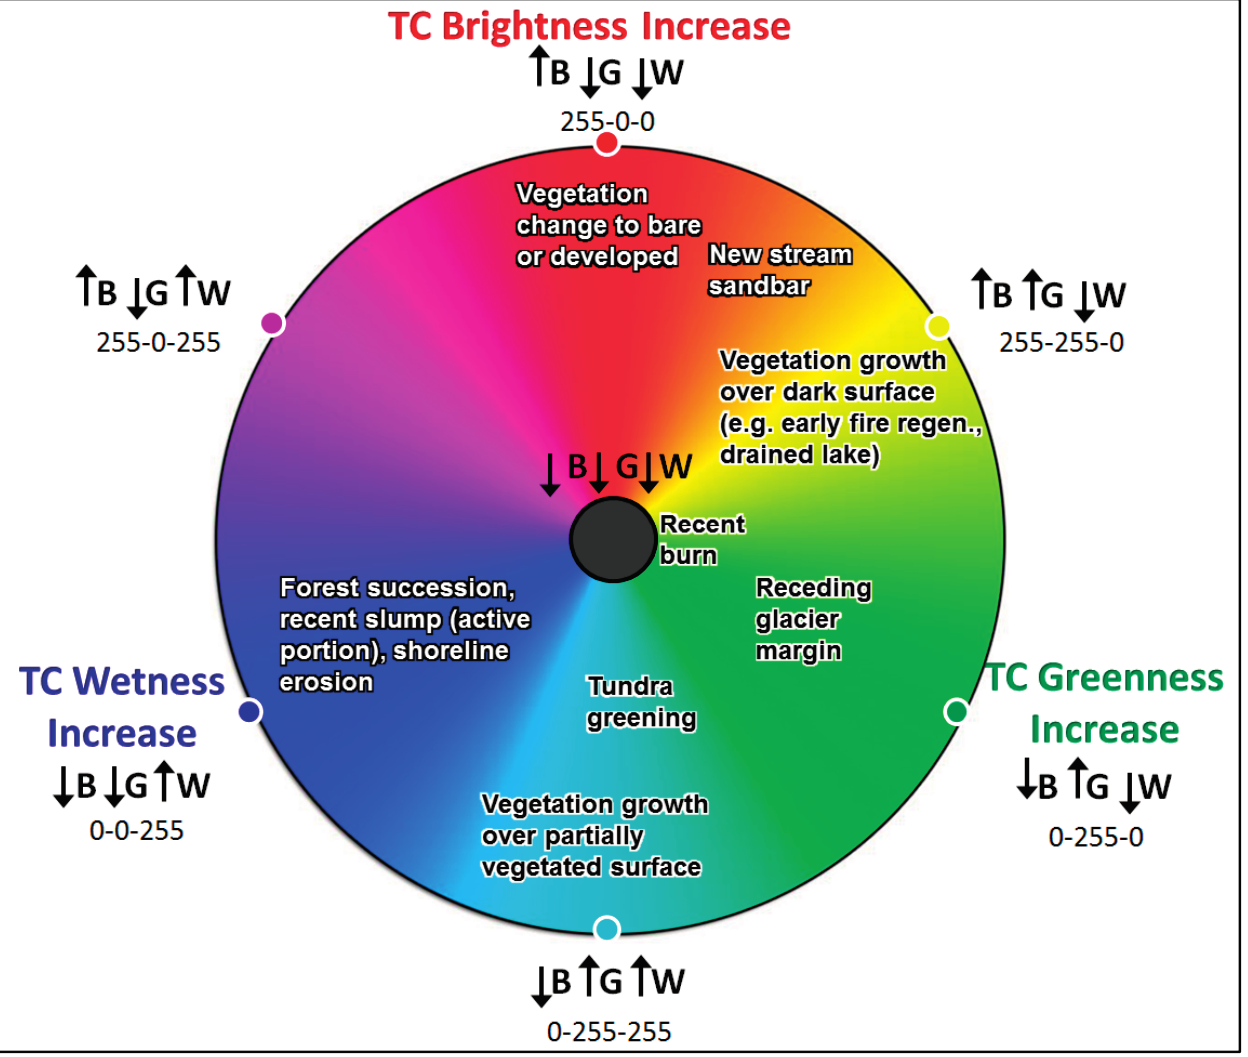
Figure 3. Color wheel legend showing the major types of landscape changes that can be interpreted from RGB compositing of the linear TC trends. The changes in each TC index that characterize each color family are shown on the outside of the color